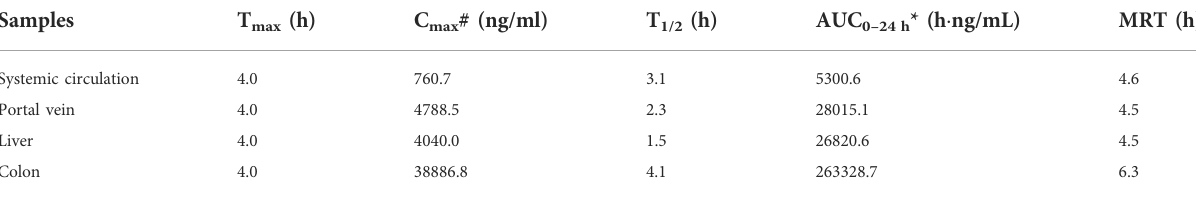
TABLE 8 Pharmacokinetic parameters of the “ integrated constituent ” in the blood or tissue samples of the mice received the oral Gegen - Qinlian decoction extract at the dosage of 6.1 g/kg.